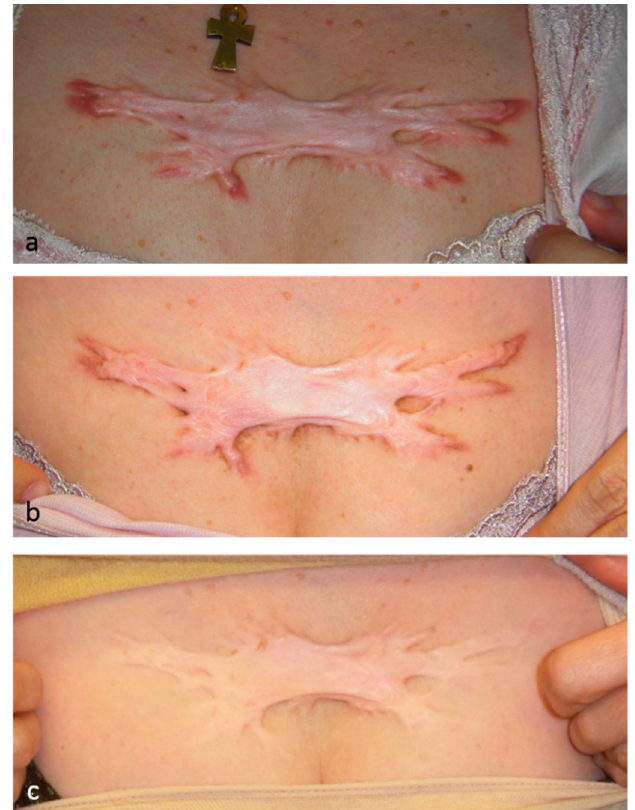
Figure 2. This 51-year-old female had a minor chest wall keloid that was treated by high-dose-rate superficial brachytherapy. A total of 25 Gy was administered in five fractions over 5 days. The superficial inflammation resolved completely. After 1 year of treatment, both the subjective and objective symptoms had improved dramatically. ( a ) Pretreatment view; ( b ) 6 months post-treatment; and ( c ) 4 years post-treatment.